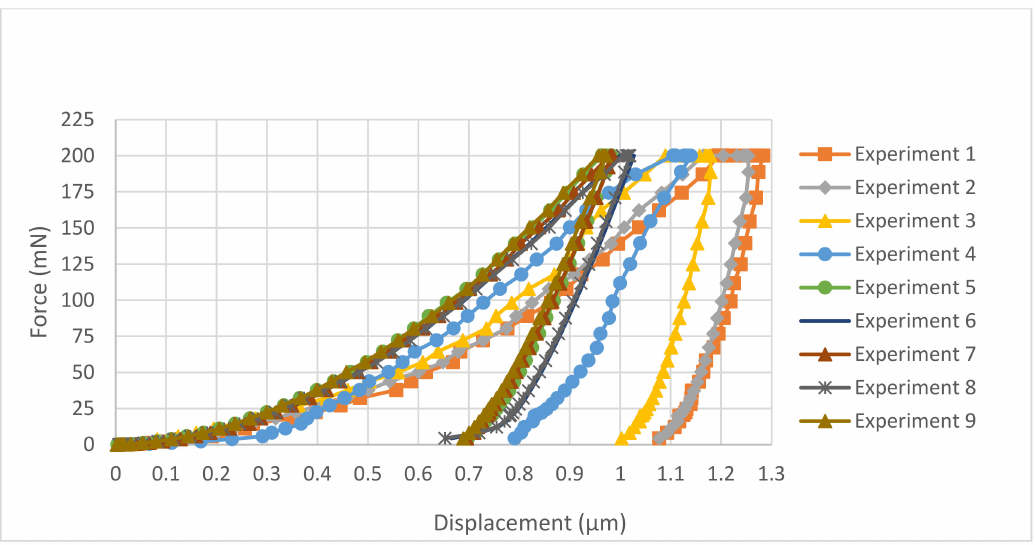
Figure 9. Load vs. displacement graph.